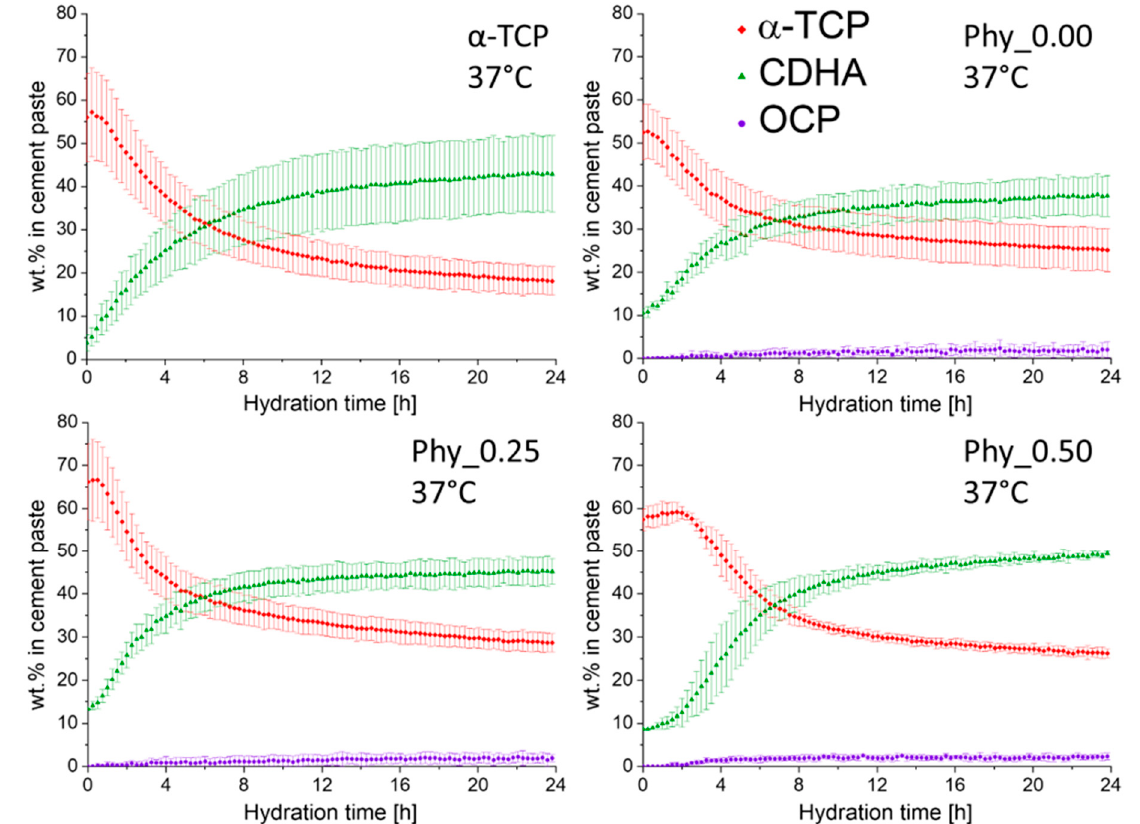
Figure 7. The quantitative in-situ XRD results of samples composed of α –TCP and CDHA (weight ratio 9:1) with different amounts of sodium phytate; a 0.2 M Na 2 HPO 4 aqueous solution was used as the mixing liquid with an L/P of 0.3 ml/g Powder . The measurements were performed at T = 37 °C; three independent measurements were run for each sample, and the error bars represent the standard deviation; the data were corrected for the water loss occurring during the measurement.